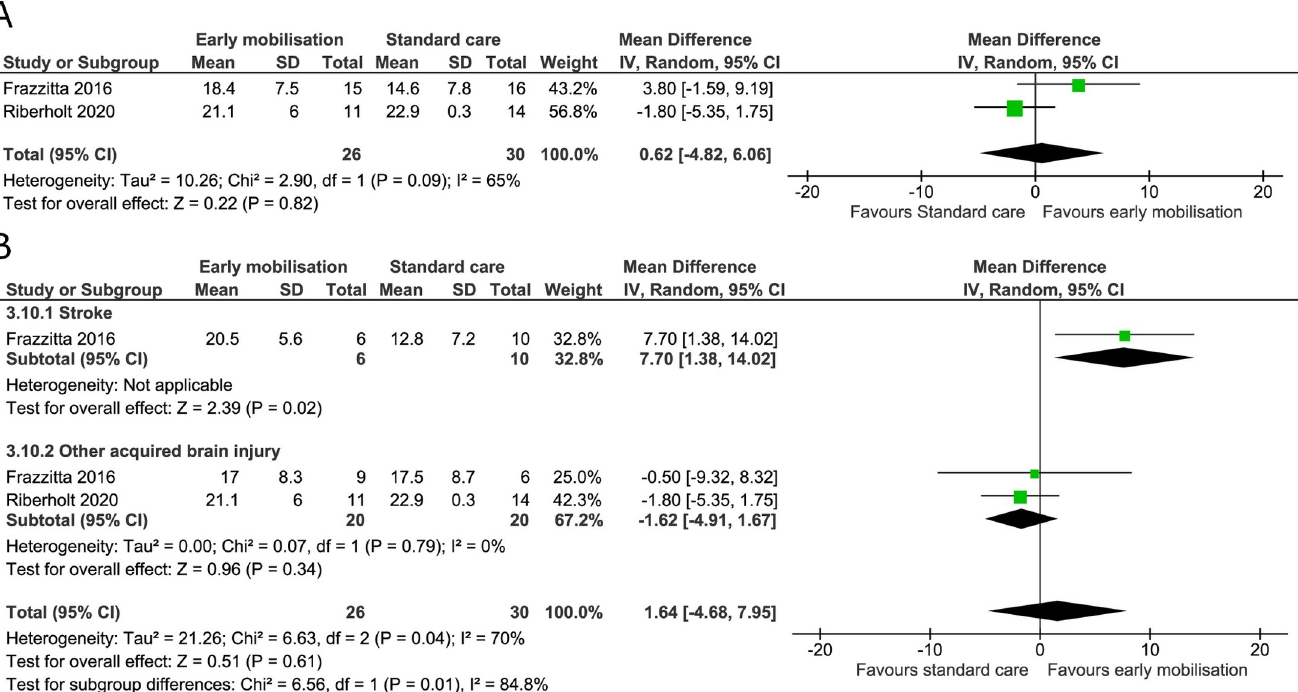
Fig 16. Comparison of early mobilisation versus standard care–Adverse events not considered serious at maximal follow-up. Fig 16A. Forest-plot showing the results from the fixed-effect meta-analysis of the outcome adverse events not considered serious at the maximal follow-up with subgroup divided according to risk of bias.